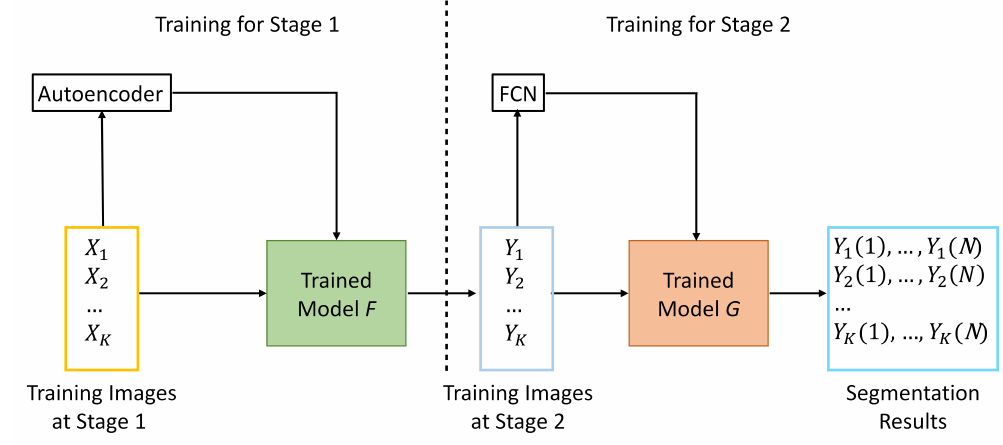
Figure 6. Procedure for the training of AE and